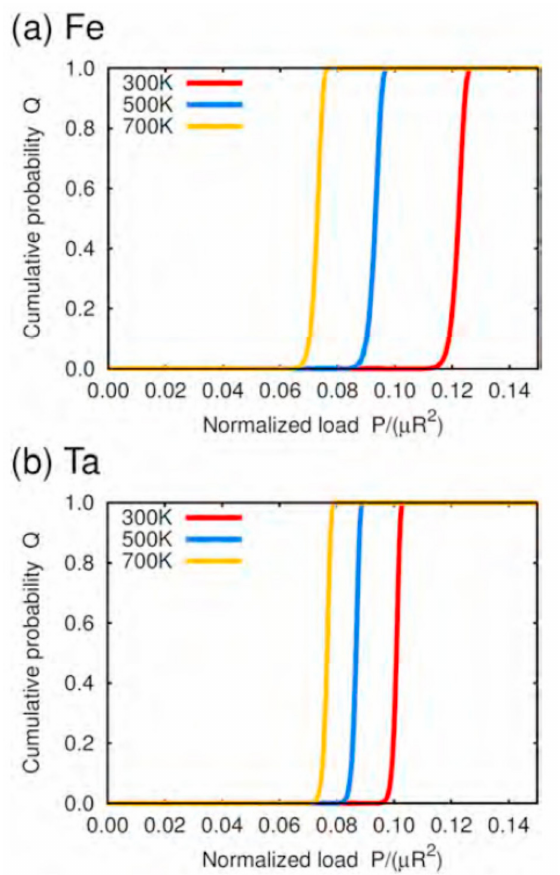
Figure 16. Predicted temperature dependence of the pop-in event in ( a ) Fe and ( b ) Ta [178]. The vertical axis is the pop-in cumulative probability, Q, while the horizontal axis is the normalized load (P, µ , and R are load, shear modulus, and indenter radius,